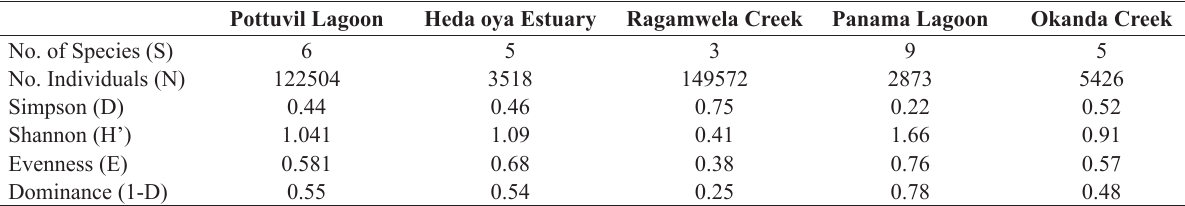
Table 4: Diversity indices obtained for studied mangrove